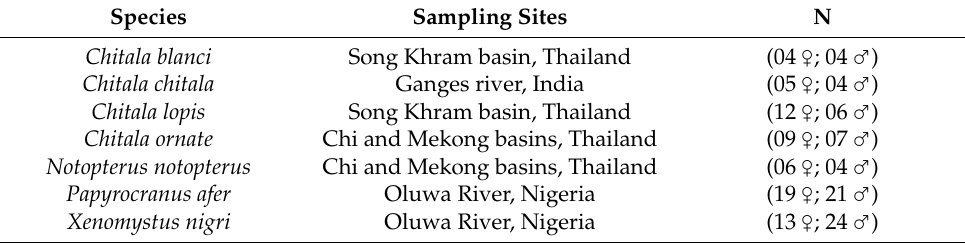
Figure 1. Map showing the origins of the specimens of seven notopterid species examined in this study. Localities 1 and 2 in Nigeria, 3 in India, and 4 to 7 in Thailand. The geographic distribution of the living species of Notopteridae is shown in red. Table 2. Collection sites of the Notopteridae species and number of individuals analyzed in this study.